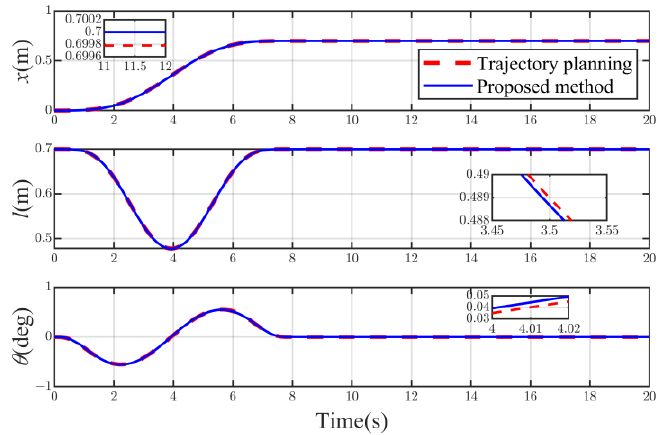
Figure 4. Trolly displacement, rope length, and payload swing angle without external disturbances.